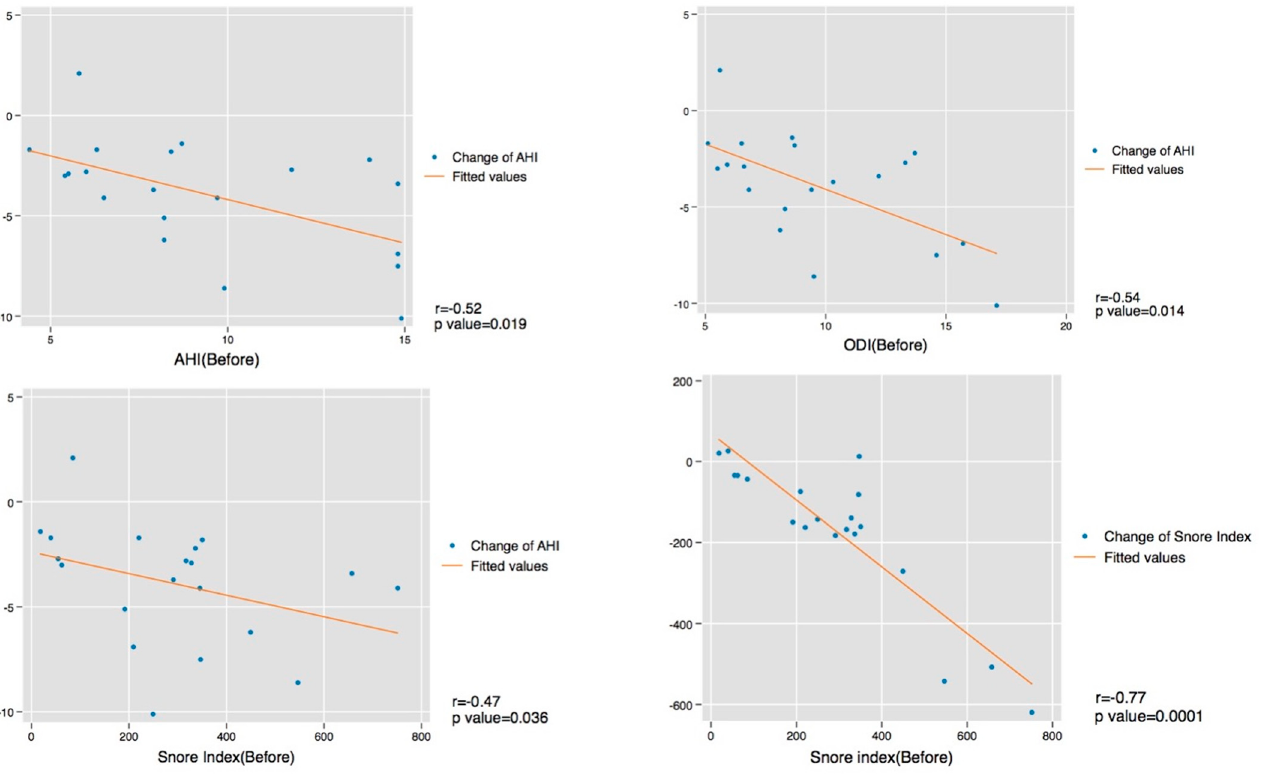
Figure 4. Correlation tests between variables (including the change of AHI from baseline AHI, ODI, and snoring index, and the change in snoring index from baseline snoring index).